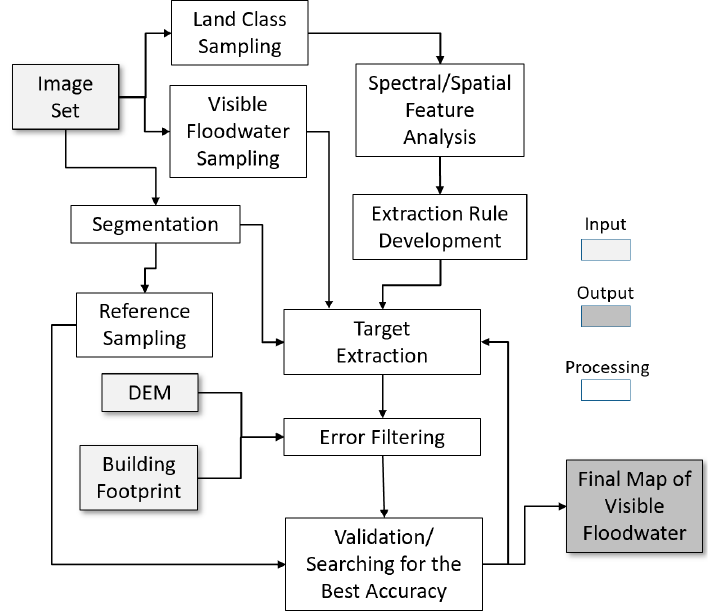
Figure 6. Outline of methodology development for visible floodwater mapping.